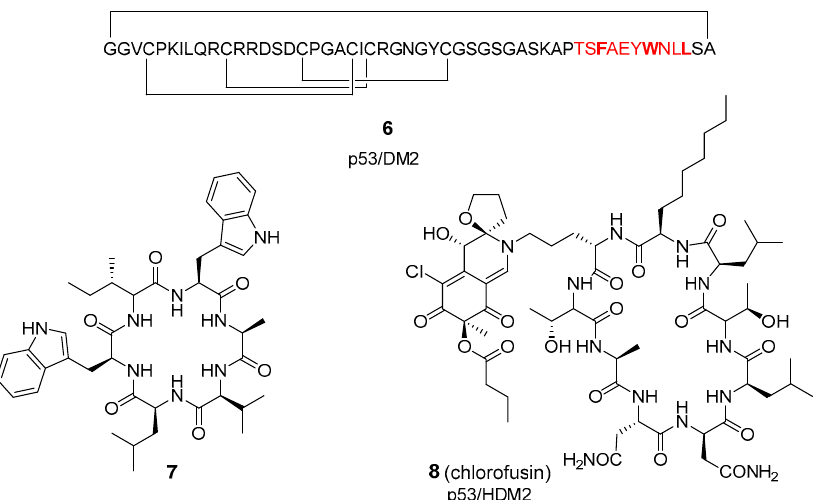
Figure 2. Selected examples of cyclic peptides isolated from natural sources or obtained after modification of naturally-occurring cyclopeptides.